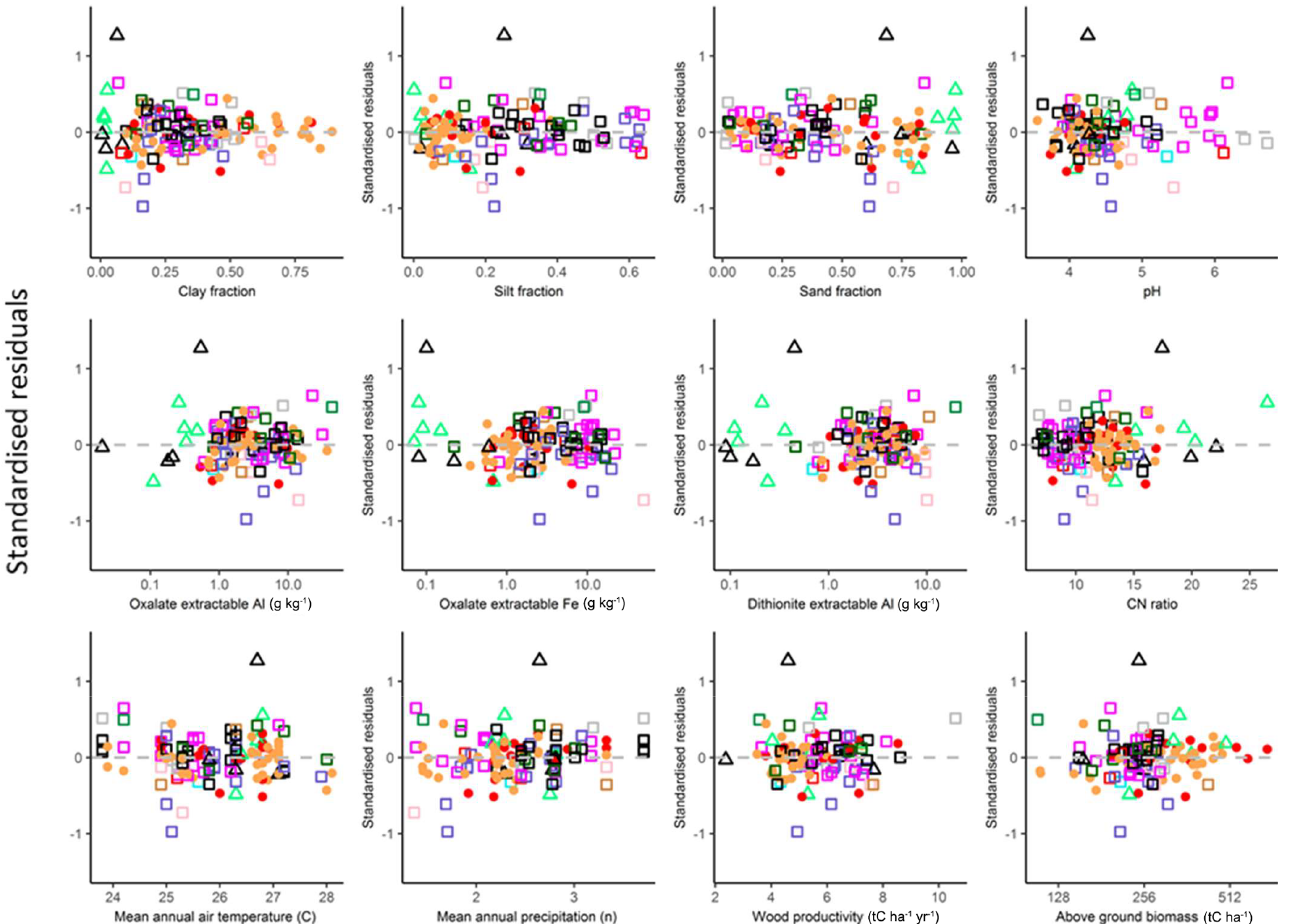
Figure A1. Standardised regression model residuals plotted against selected climatic, edaphic and vegetation